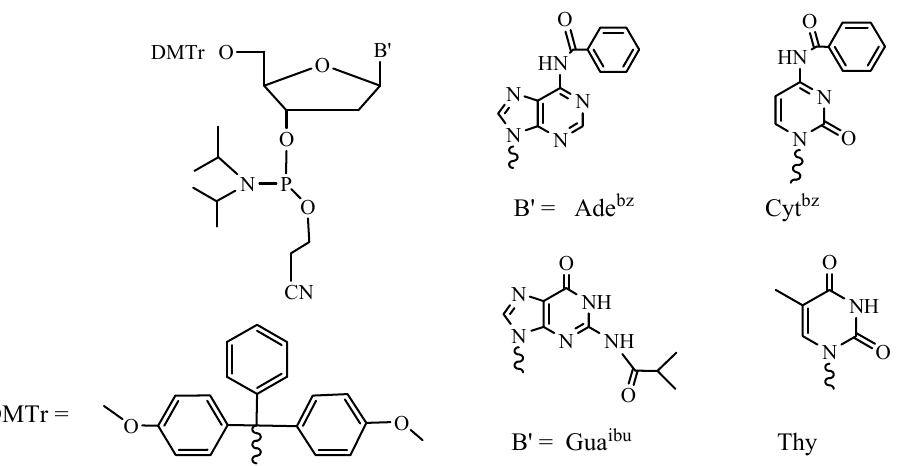
Figure 3. Standard phosphoramidites used in ODN